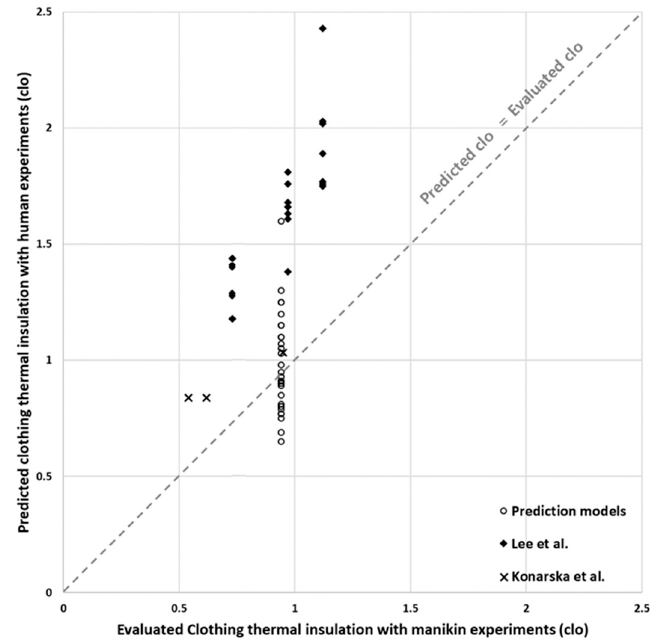
Figure 9. Predicted clothing insulation (four prediction models of the present study, Konarska et al. [6], and Lee et al. [12]).